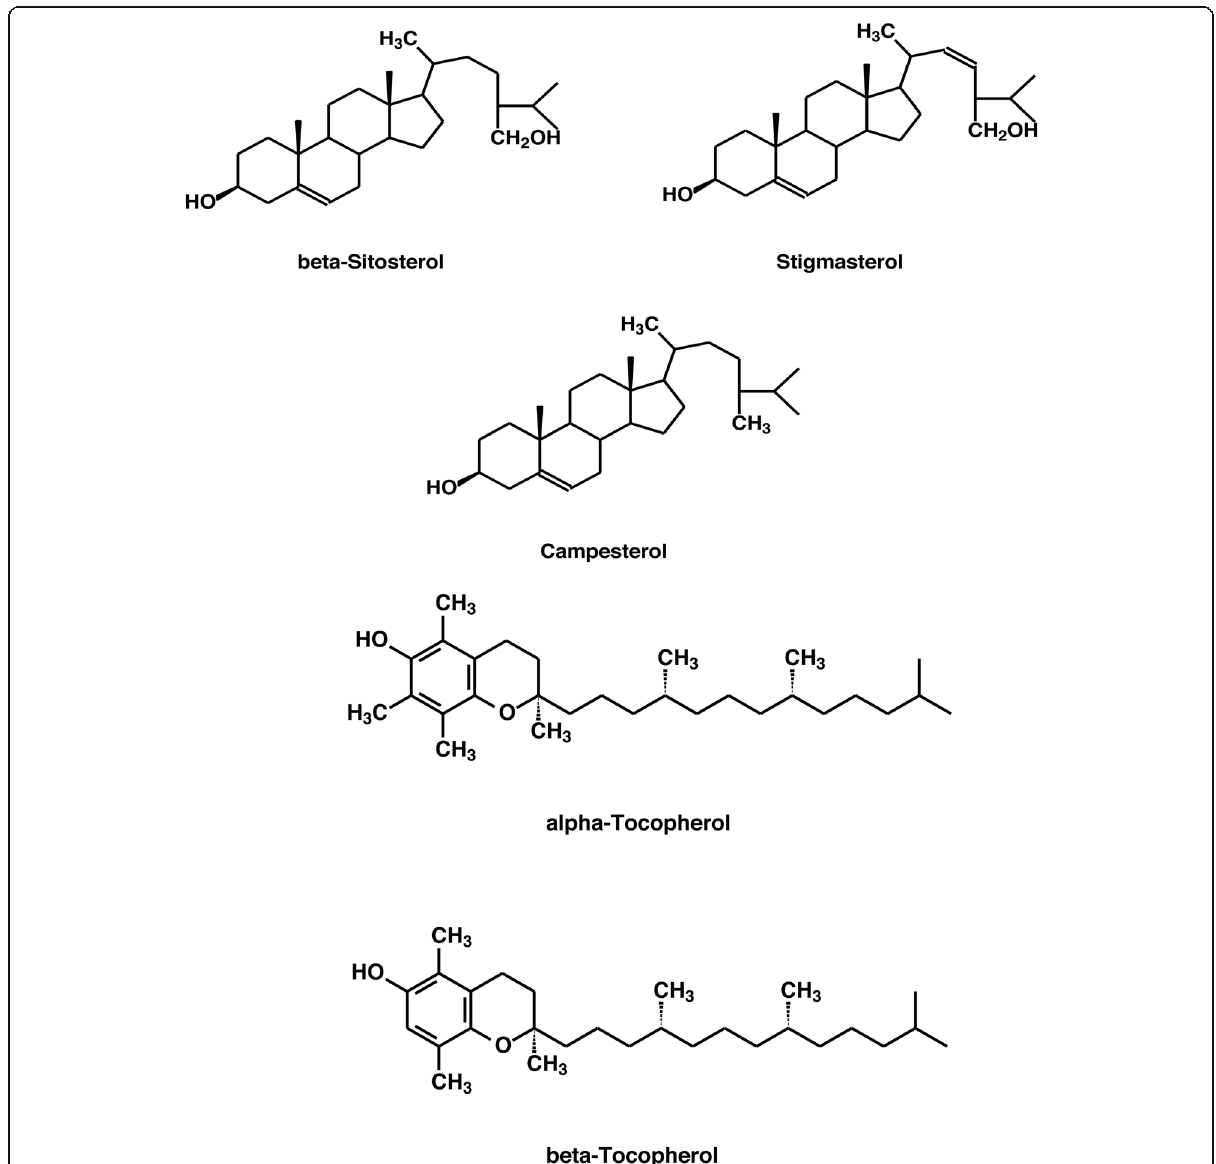
Fig. 5 Structures of the major vitamers and sterols detected in hexane extract of Melissa officinalis